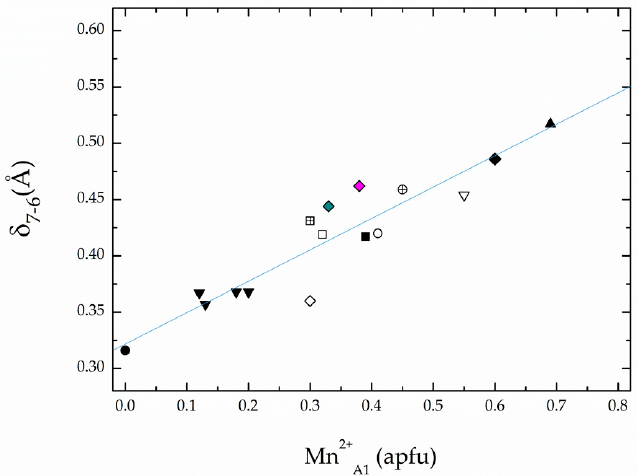
Figure 5. Relation between the δ 7-6 value (in Å) and the Mn 2+ content at the A (1) site. The equation of the regression line is: δ 7-6 = 0.32(1) + 0.28(3) Mn 2+A1 ( r 2 = 0.868). Symbols refer to data from literature as follows: solid circle = piemontite [20]; solid downward triangle = REE -bearing piemontite [21]; open diamond = ferriakasakaite-(La) [22]; open square = REE -bearing piemontite [19]; crossed open square = ( REE ,Pb)-rich piemontite [23]; solid square = vanadoallanite-(La) [24]; open circle = Mn 2+ -rich piemontite [25]; crossed open circle = ferriakasakaite-(La) [2]; open downward triangle = ferriandrosite-(La) [2]; solid diamond = manganiandrosite-(La) [19] and manganiandrosite-(Ce) [10]; solid upward triangle = vanadoandrosite-(Ce) [10]. Blue and purple diamonds refer to ferriakasakaite-(Ce) and manganiakasakaite-(La), respectively (this study).